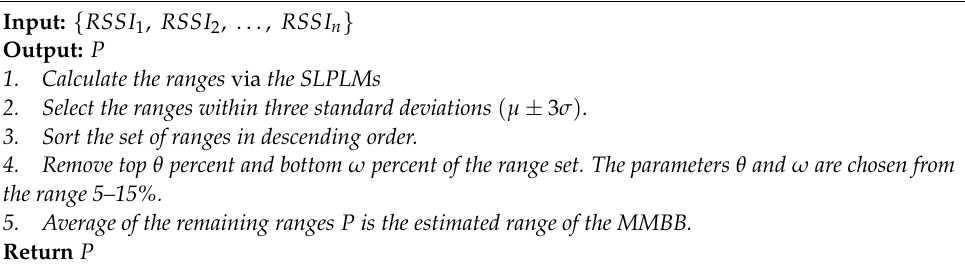
Algorithm 1. MMBB-Based Range Estimation